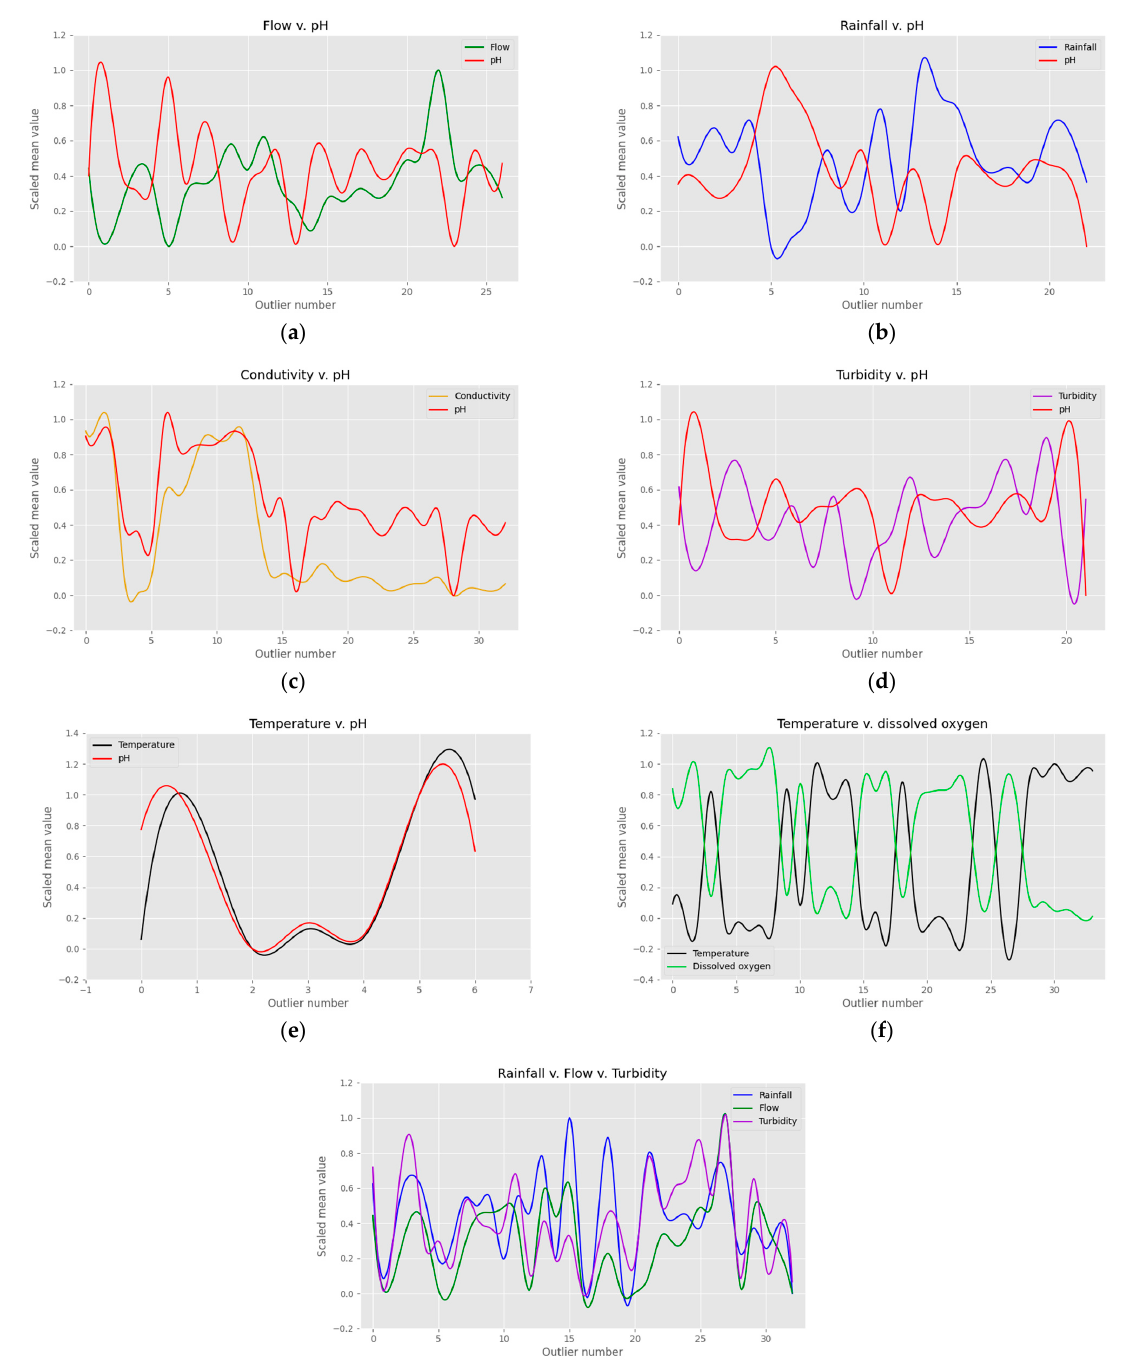
Figure 7. Outlier correlation analysis between variables in the database. The horizontal axis contains the number of outlying weeks that are coincidental in time between the variables studied in each case, while the vertical axis of the plot represents the scaled mean values between 1 and 0 of their corresponding variable in each matching week: ( a ) plot of the relationship analysis between flow and pH; ( b ) plot of the relationship analysis between rainfall and pH; ( c ) plot of the relationship analysis between conductivity and pH; ( d ) plot of the relationship between the turbidity and pH; ( e ) plot of the relationship analysis between temperature and pH; ( f ) plot of the relationship analysis between temperature and dissolved oxygen; and ( g ) plot of the relationship analysis between rainfall, flow, and